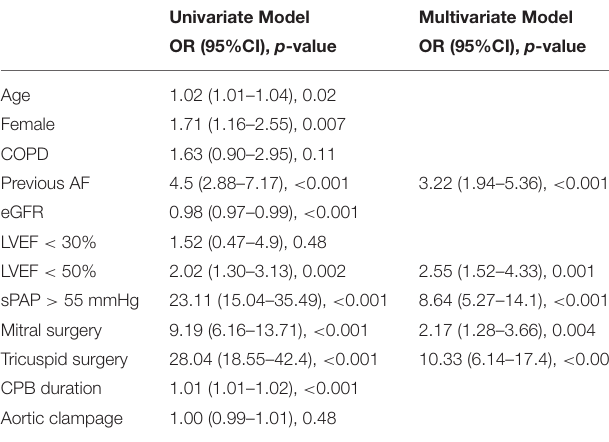
TABLE 3 | Variables associated with post-operative right ventricular failure.